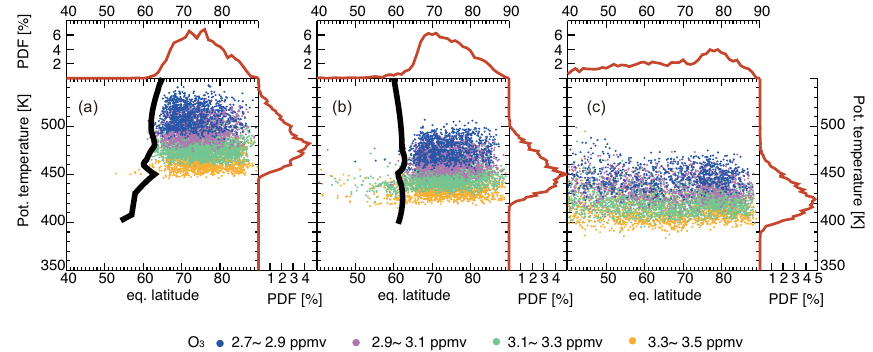
Figure 10. Spatial distribution in the eq. latitude- θ space of the APs, defined by the mixing ratios of N 2 O and p O 3 inside the square in Fig. 9a3, i.e. with N 2 O and p O 3 values from 80 to 130 and from 2.7 to 3.5ppmv, respectively, calculated from the CLaMS run without mixing. (a) 23 December 2008; (b) 23 January 2009 and (c) 23 February 2009. Colours indicate different ranges of p O 3 values and are defined in the box. The PDFs along the eq. latitude and potential temperature axes are shown as red lines. Thick black lines denote the edge of the polar